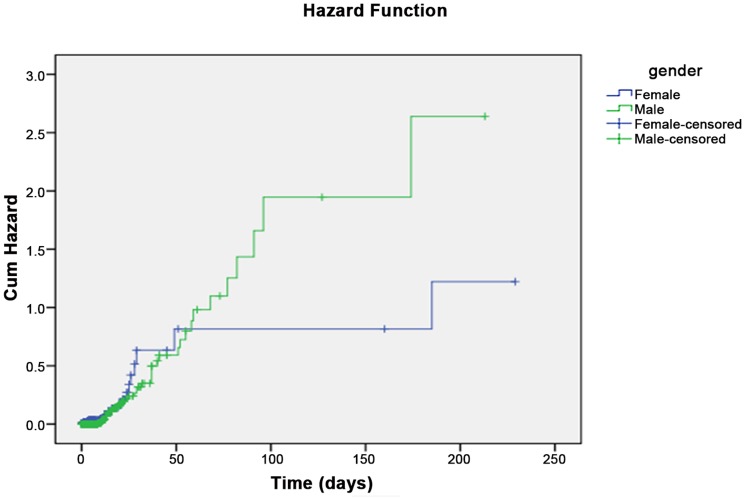
Plot of the Cumulative Hazard function for the data to test the assumption of Cox Proportional Hazard.